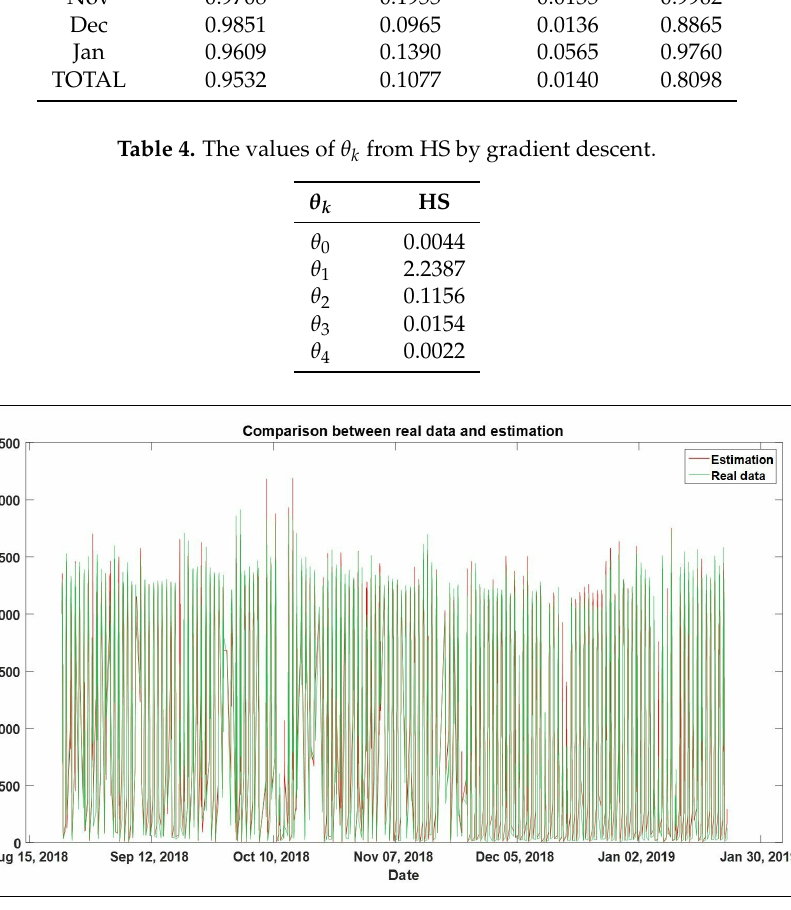
Figure 8. The results obtained from HS by gradient descent.